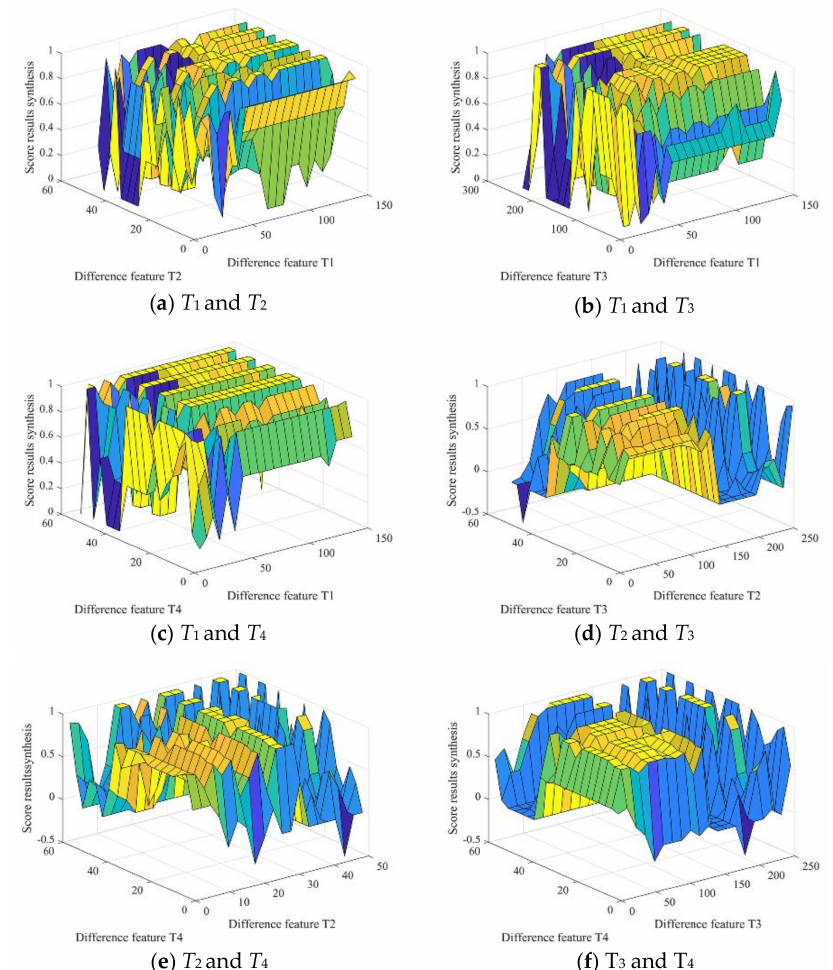
Figure 7. Aggregation of difference feature score